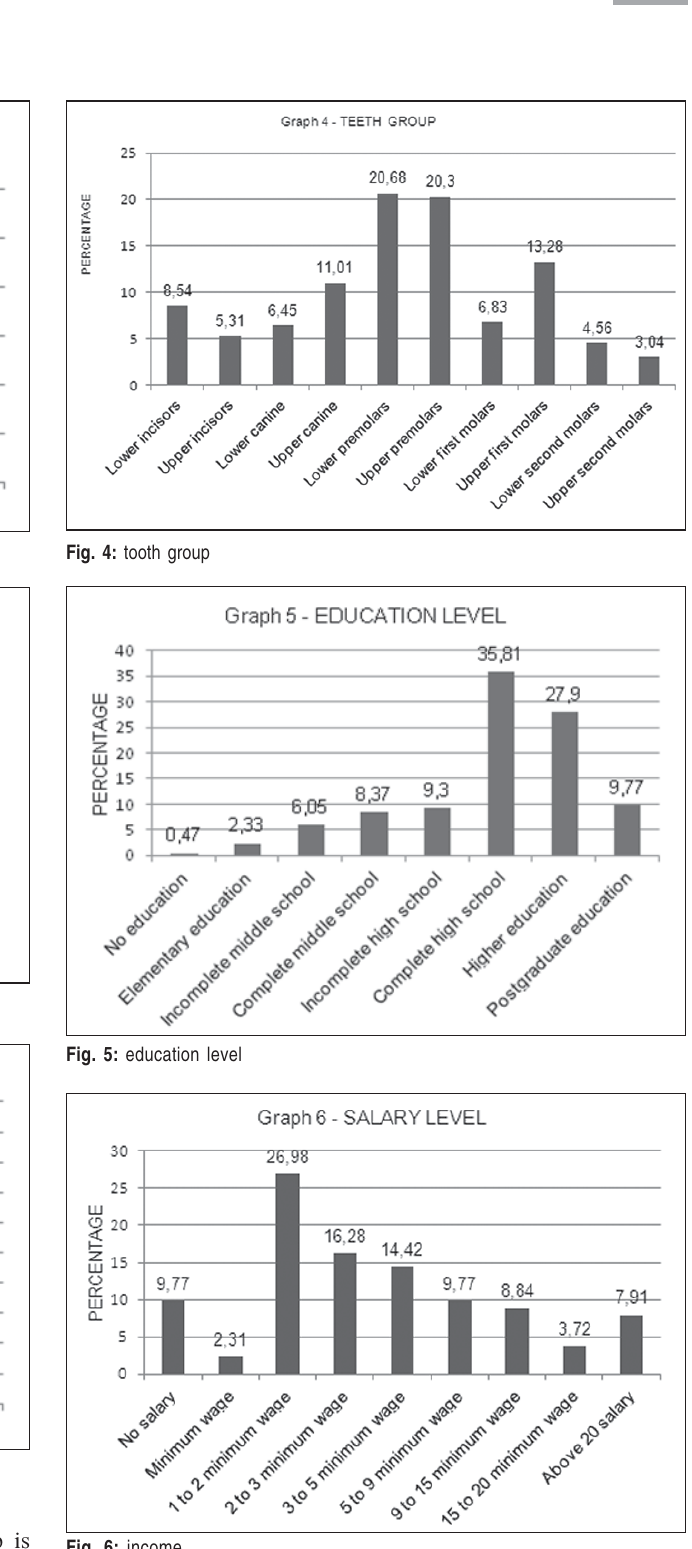
Fig. 6: income C (p=0.000). The relative percentage for each age group